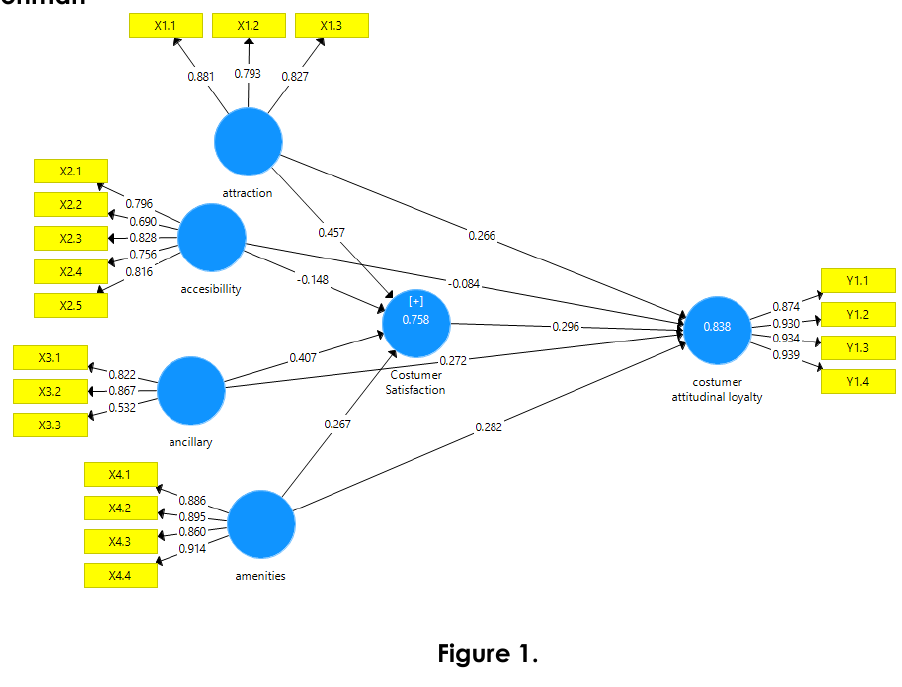
Figure 1. Path Diagram 1 Source: primary data (2019)